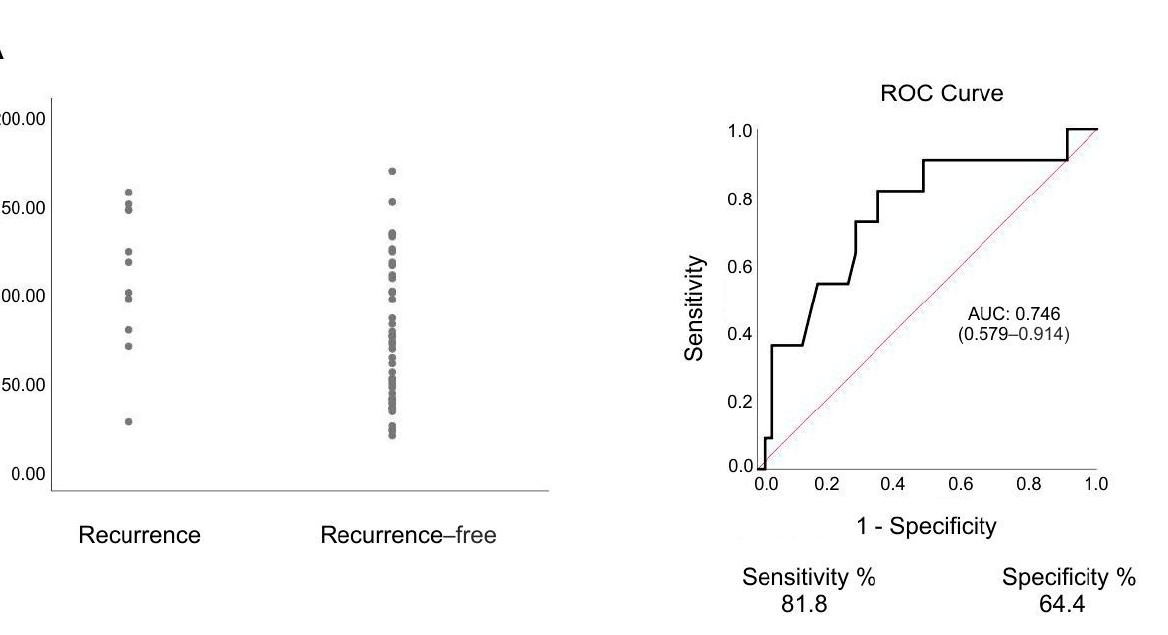
Figure 2. Serum paraoxonase-1 (PON1) activity and receiver operating characteristic (ROC) curves in patients with prostate cancer. ( A ) before radiotherapy, recurrence group vs. recurrence-free group, p = 0.012, Mann–Whitney U test. ( B ) After radiotherapy, recurrence group vs. recurrence-free group, p = 0.017, Mann–Whitney U test. 4. Discussion PON1 is one of a family of three enzymes, called PON1, PON2 and PON3, which degrade lipid peroxides in circulating lipoproteins and in the cytoplasmic and intracel- lular organelle membranes of cells [21]. These enzymes are linked to mitochon- dria-associated membranes, which modulate mitochondrial metabolism and prevent apoptosis. There are variations of serum PON1 activity in the population. One source of the variability is the polymorphism in the coding and in the promoter region of the PON1 gene. There are also exogenous factors modulating PON1 activity and levels of expres- sion, such as certain drugs, dietary factors, and lifestyle factors. Costa et al., in their re-